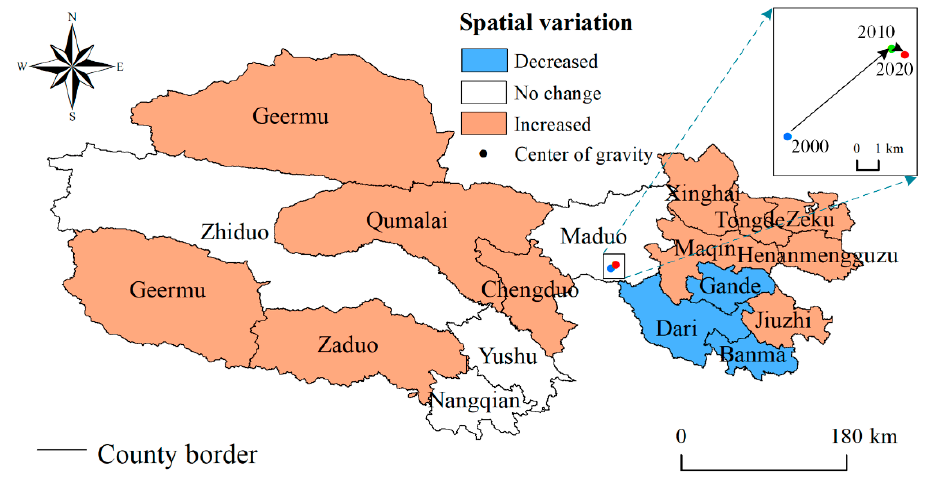
Figure 5. Spatial changes and shifts in the center of gravity of the material index (MI) in the Sanjiangyuan area during 2000–2020.